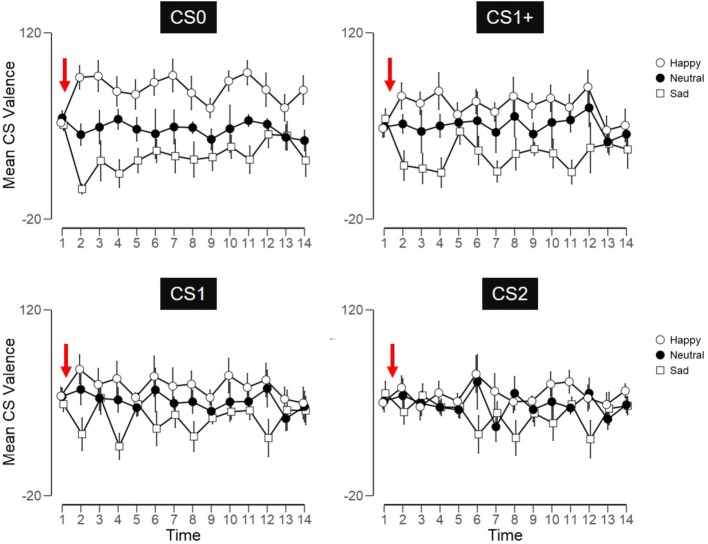
CS valences were collected across 14 time points (x-axis) and were scored from 1/sad to 100/happy (y-axis). Conditioning took place between times 1 and 2 (red arrow). All subsequent evaluations were spaced 2–3 days apart. Error bars indicate 95% confidence intervals.